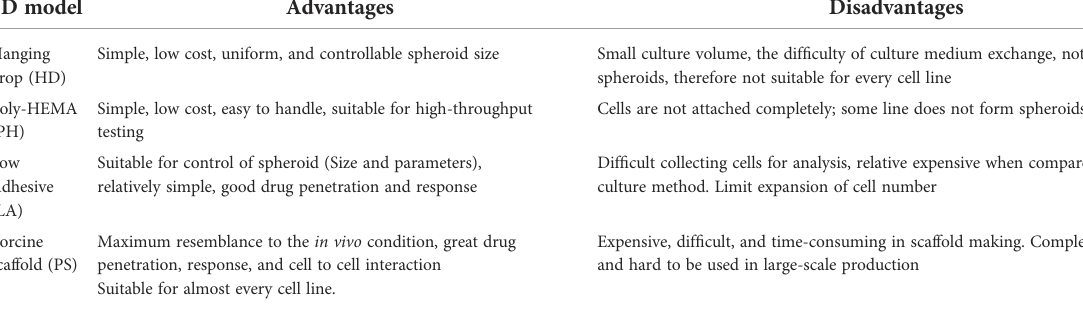
TABLE 2 Advantages and disadvantages of the 3D cell culture